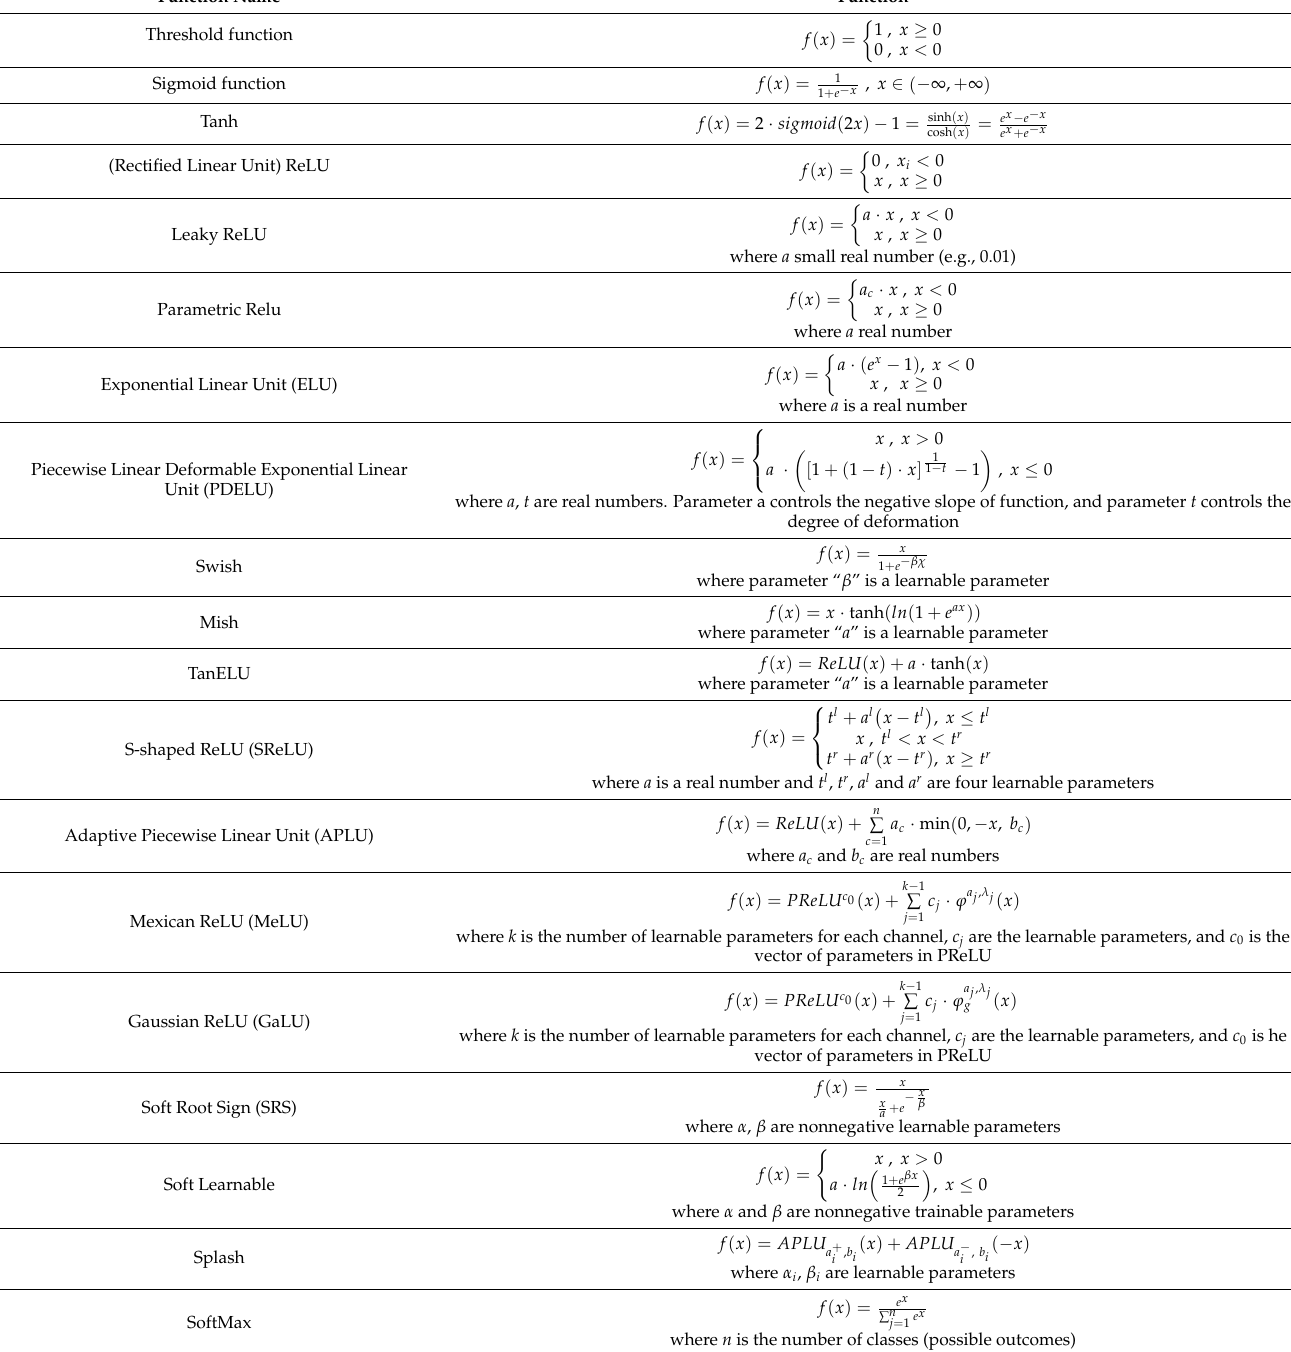
Table 1. Most known activation functions in NNs